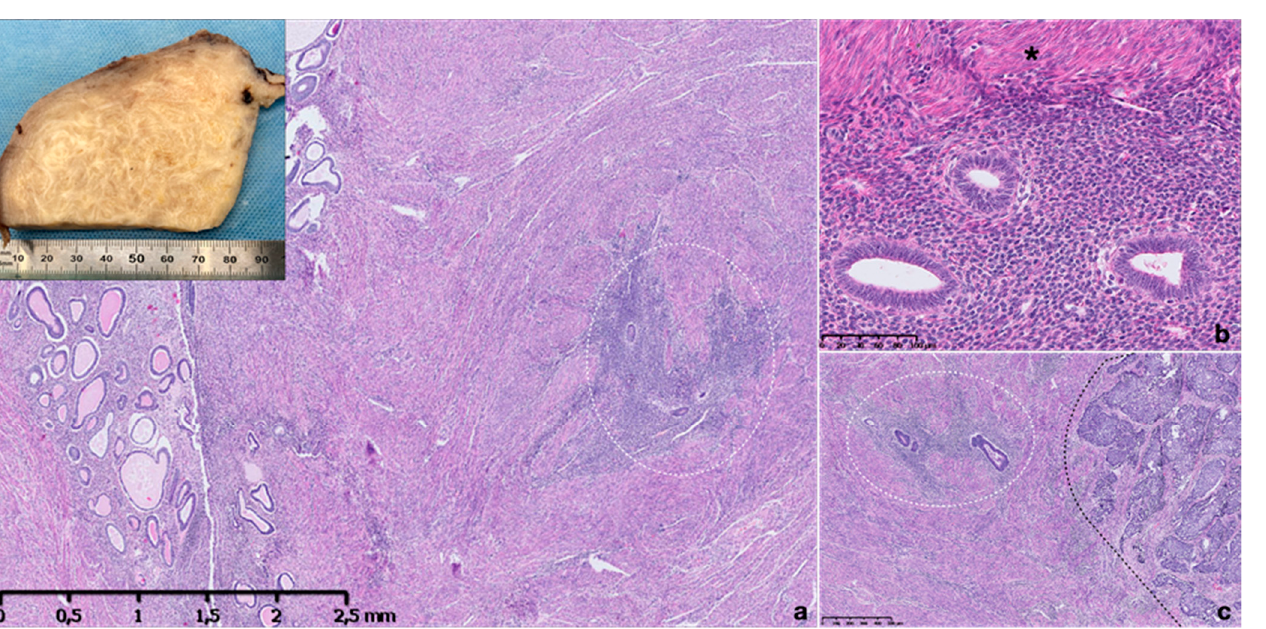
Figure 1. Macroscopic and microscopic appearance of adenomyosis. Thickened and trabeculated appearing myometrial wall with ill-defined hypertrophic swirls of smooth muscle of sectioned uterus with adenomyosis ( a, inset). Histopathological image of uterine adenomyosis observed in hysterectomy specimen, with endometrial glandular and stroma invading the muscular myometrium (within circle) ( a ). Higher-power view showing ectopic endometrial glands and stroma surrounded by hyperplastic myometrium (asterisk) ( b ). Ectopic glandular epithelium is proliferative type and stroma is inactive, non-mitotic and composed of monotonous cells ( b ). A specimen showing an endometroid carcinoma infiltrating myometrial wall on the right (black line) and adenomyosis foci on the left (within line) ( c ). Hematoxylin and eosin stain.